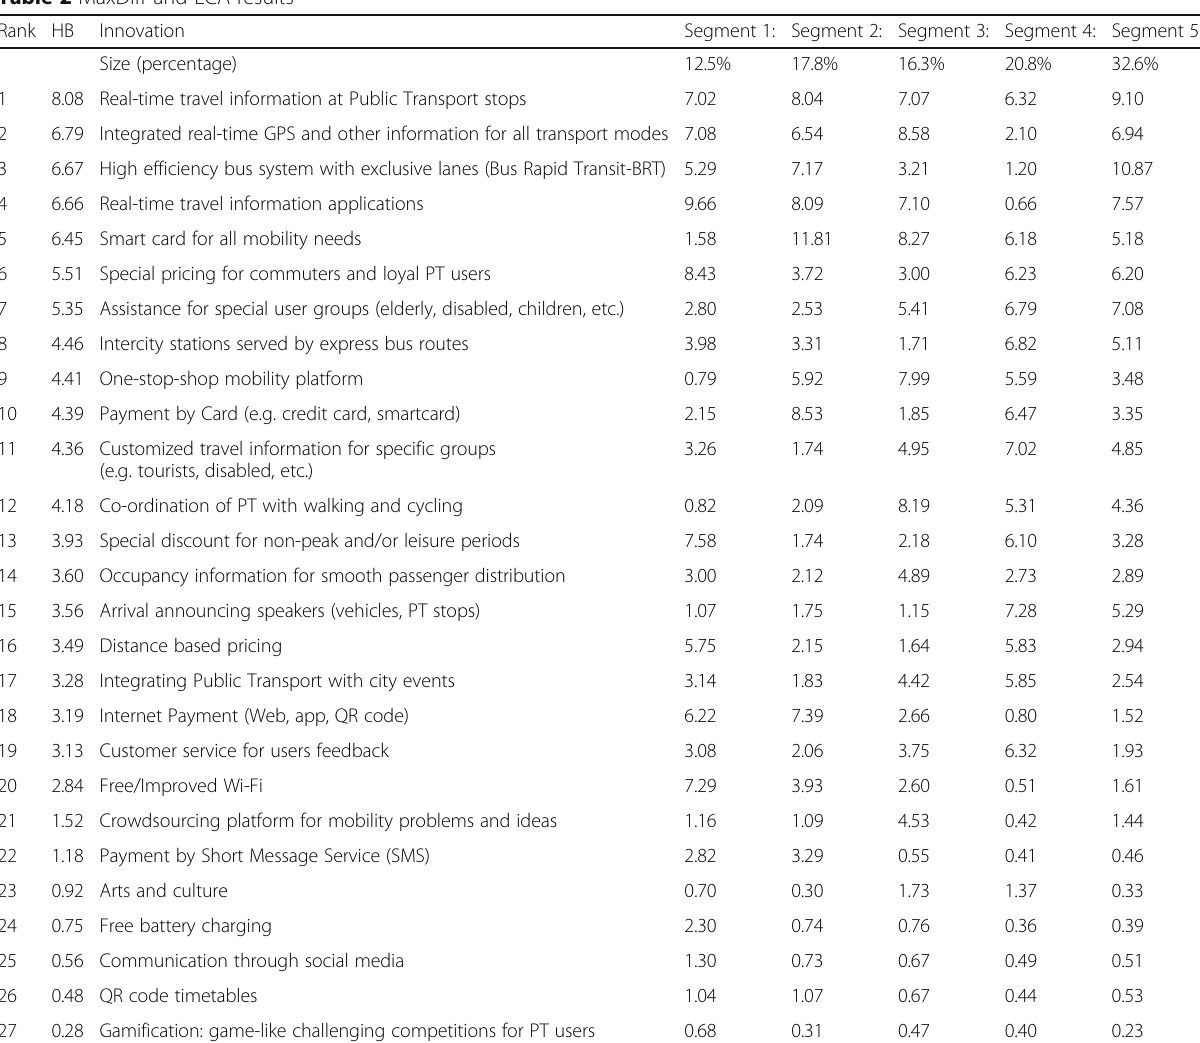
Table 2 MaxDiff and LCA results Rank HB